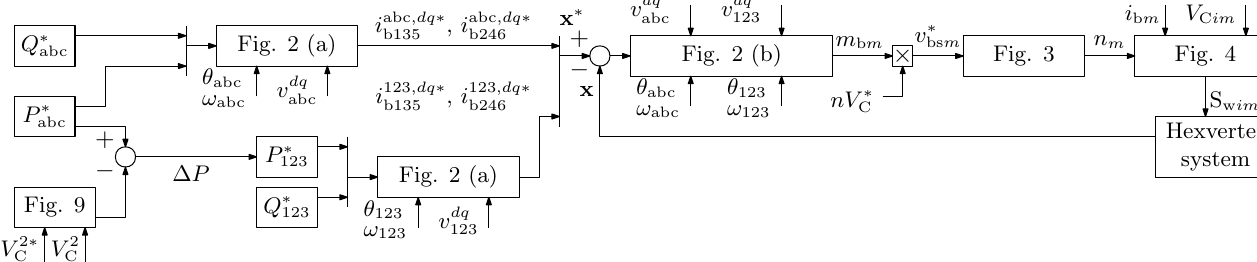
controller block diagram. C